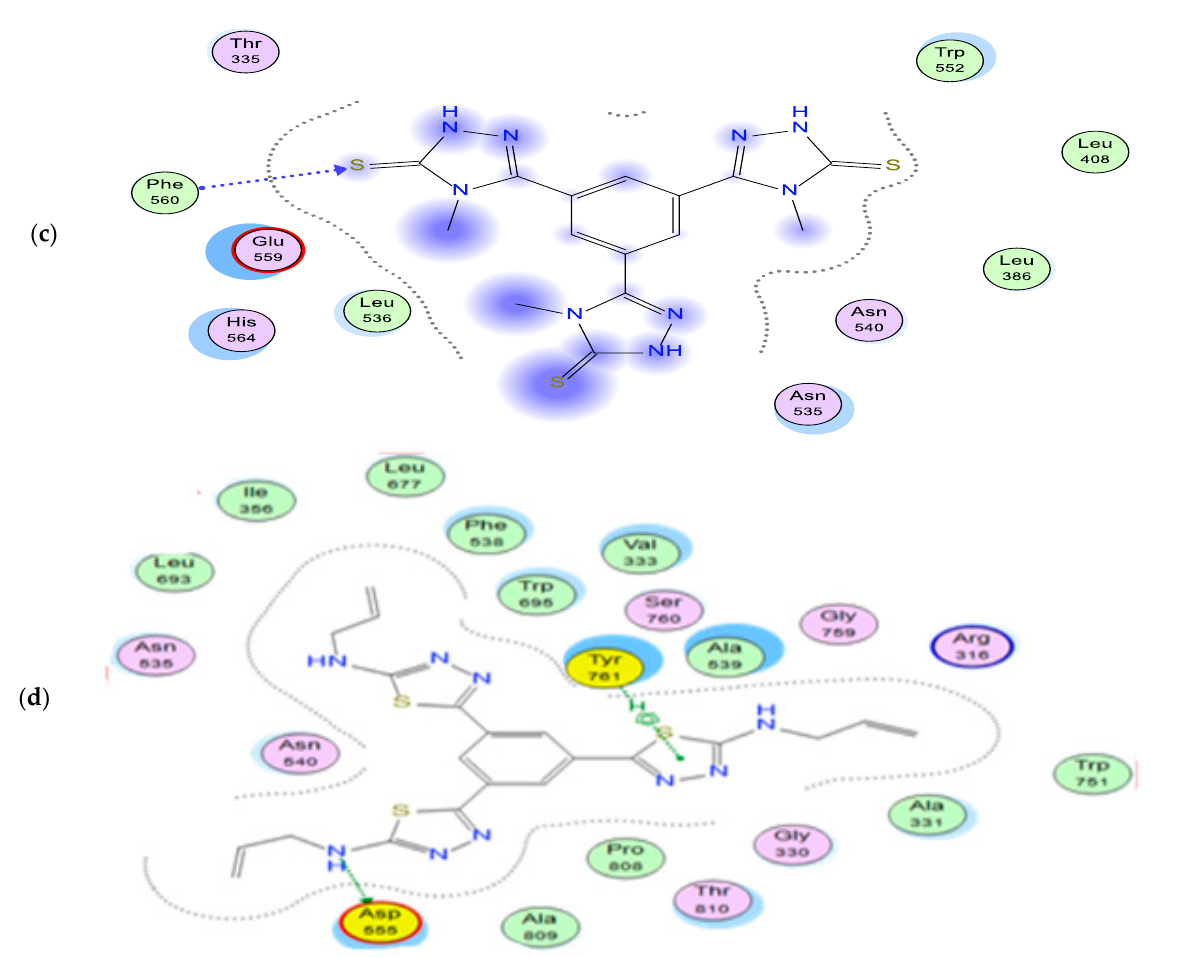
Figure 7. Two-dimensional binding mode and residues involved in the recognition of compounds ( a ) 22 , ( b ) 23 , ( c ) 18 , and ( d ) 27 ( a ) 22 , ( b ) 23 , ( c ) 18 , and ( d ) 27 ligands.